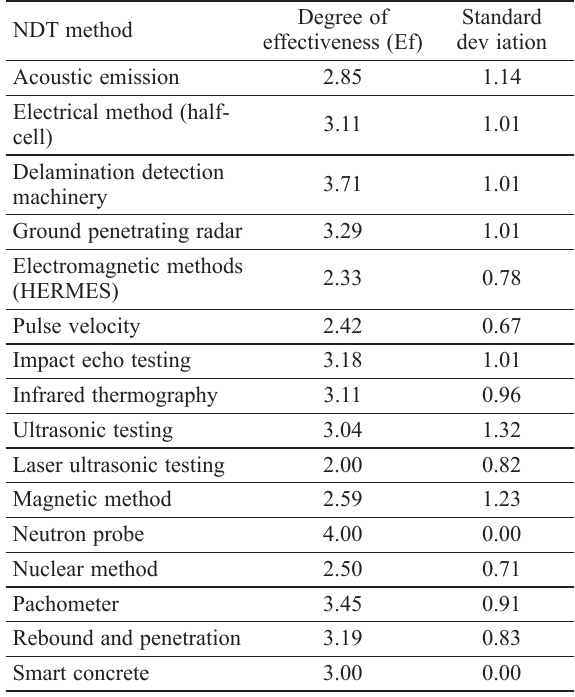
Table 10. Concrete NDT methods: effectiveness